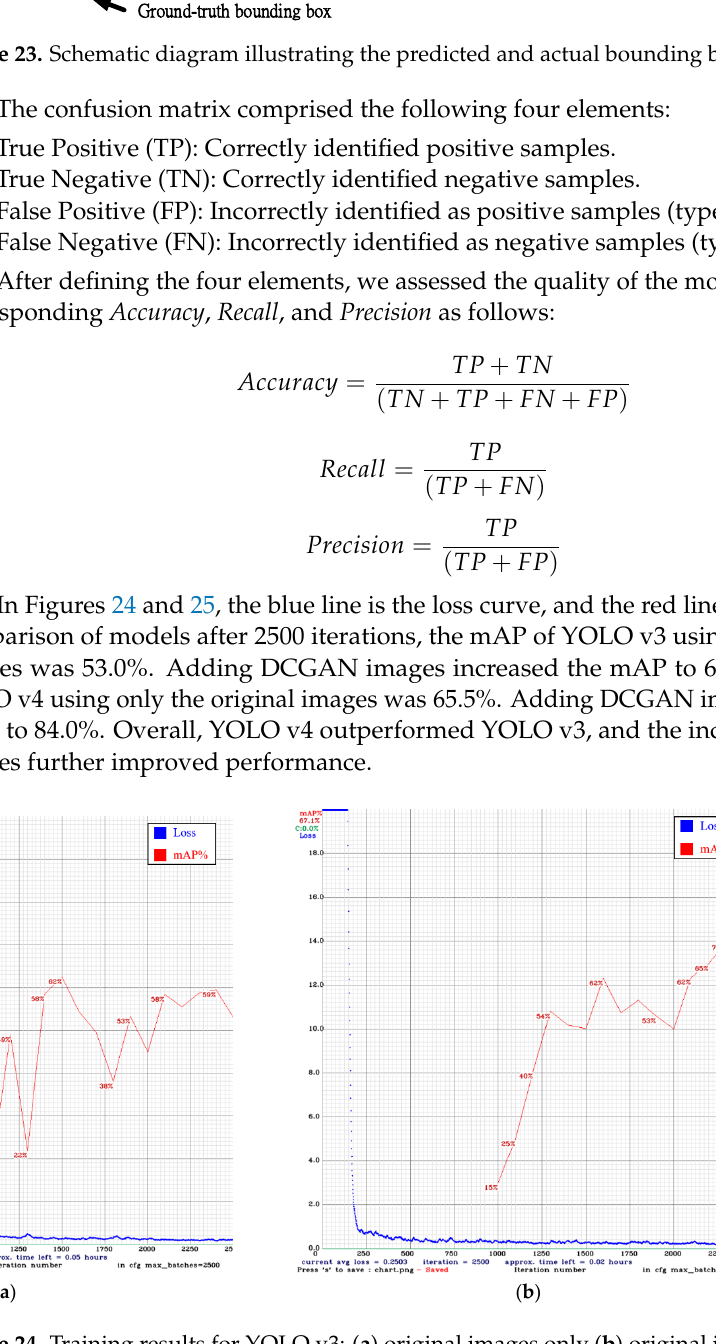
( b ) Figure 25. Training results for YOLO v4: ( a ) original images only ( b ) original images plus DCGAN synthetic images. The second stage of testing was performed using eight rims, comprising 25 defects. Model prediction data are listed in Table 3, and the calculation results are listed in Table 4. In the test results in Figure 26, defects are indicated by boxes.